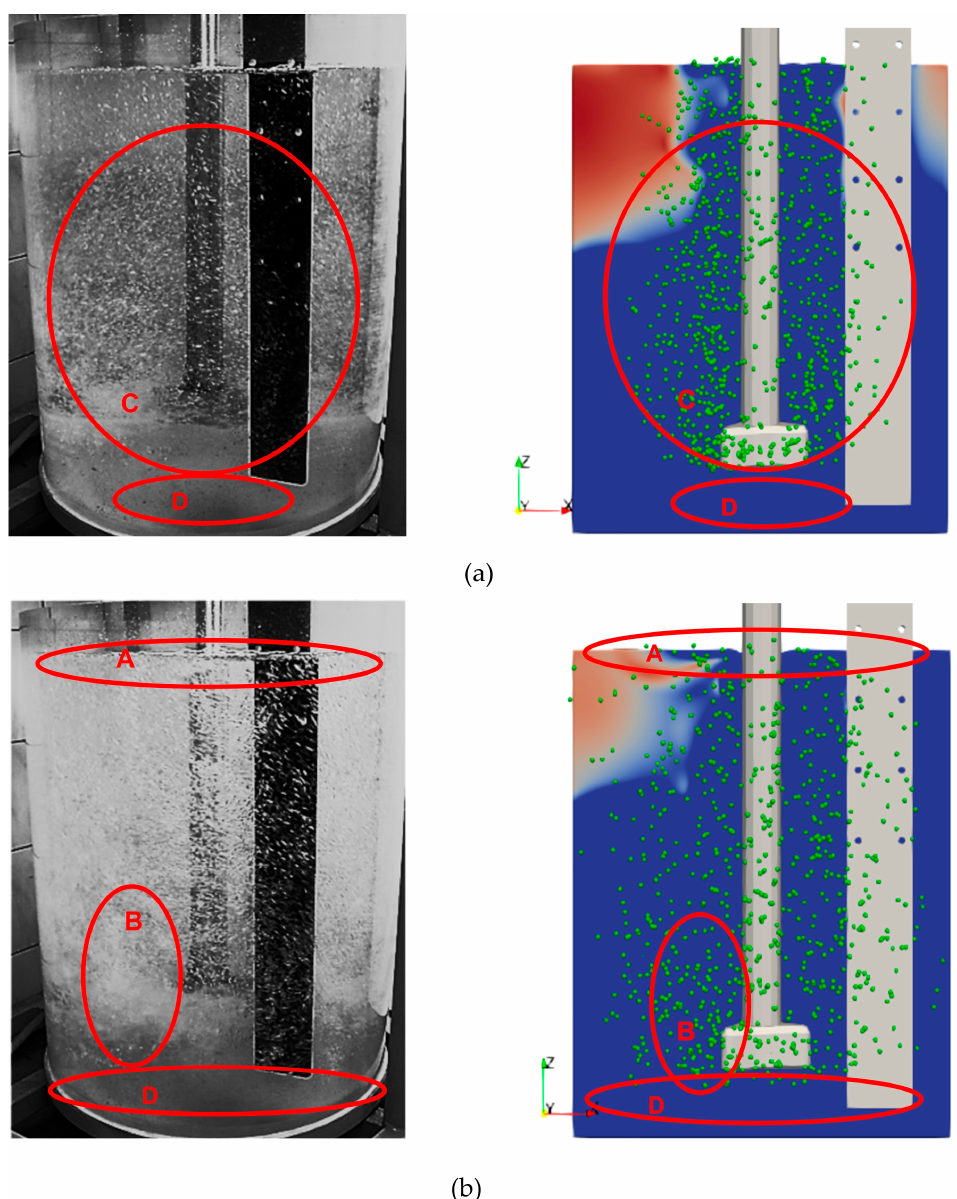
Figure 17. Compilations of model research results (CFD and physical): A—single gas bubbles formed on the surface of the modeling liquid, B—excessive formation of gas chains and swirls, C—uniform distribution of gas bubbles in the entire volume of the tank, and D—dead zones without gas bubbles, no dispersion. ( a ) Variant B; ( b ) variant F.